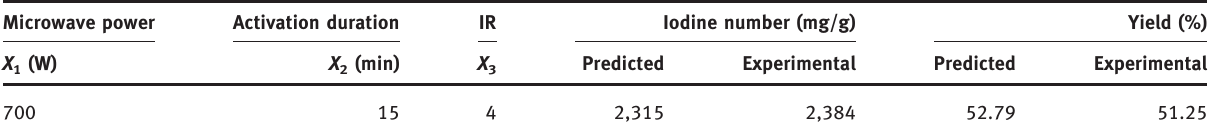
Table 6: Validation of process optimization.